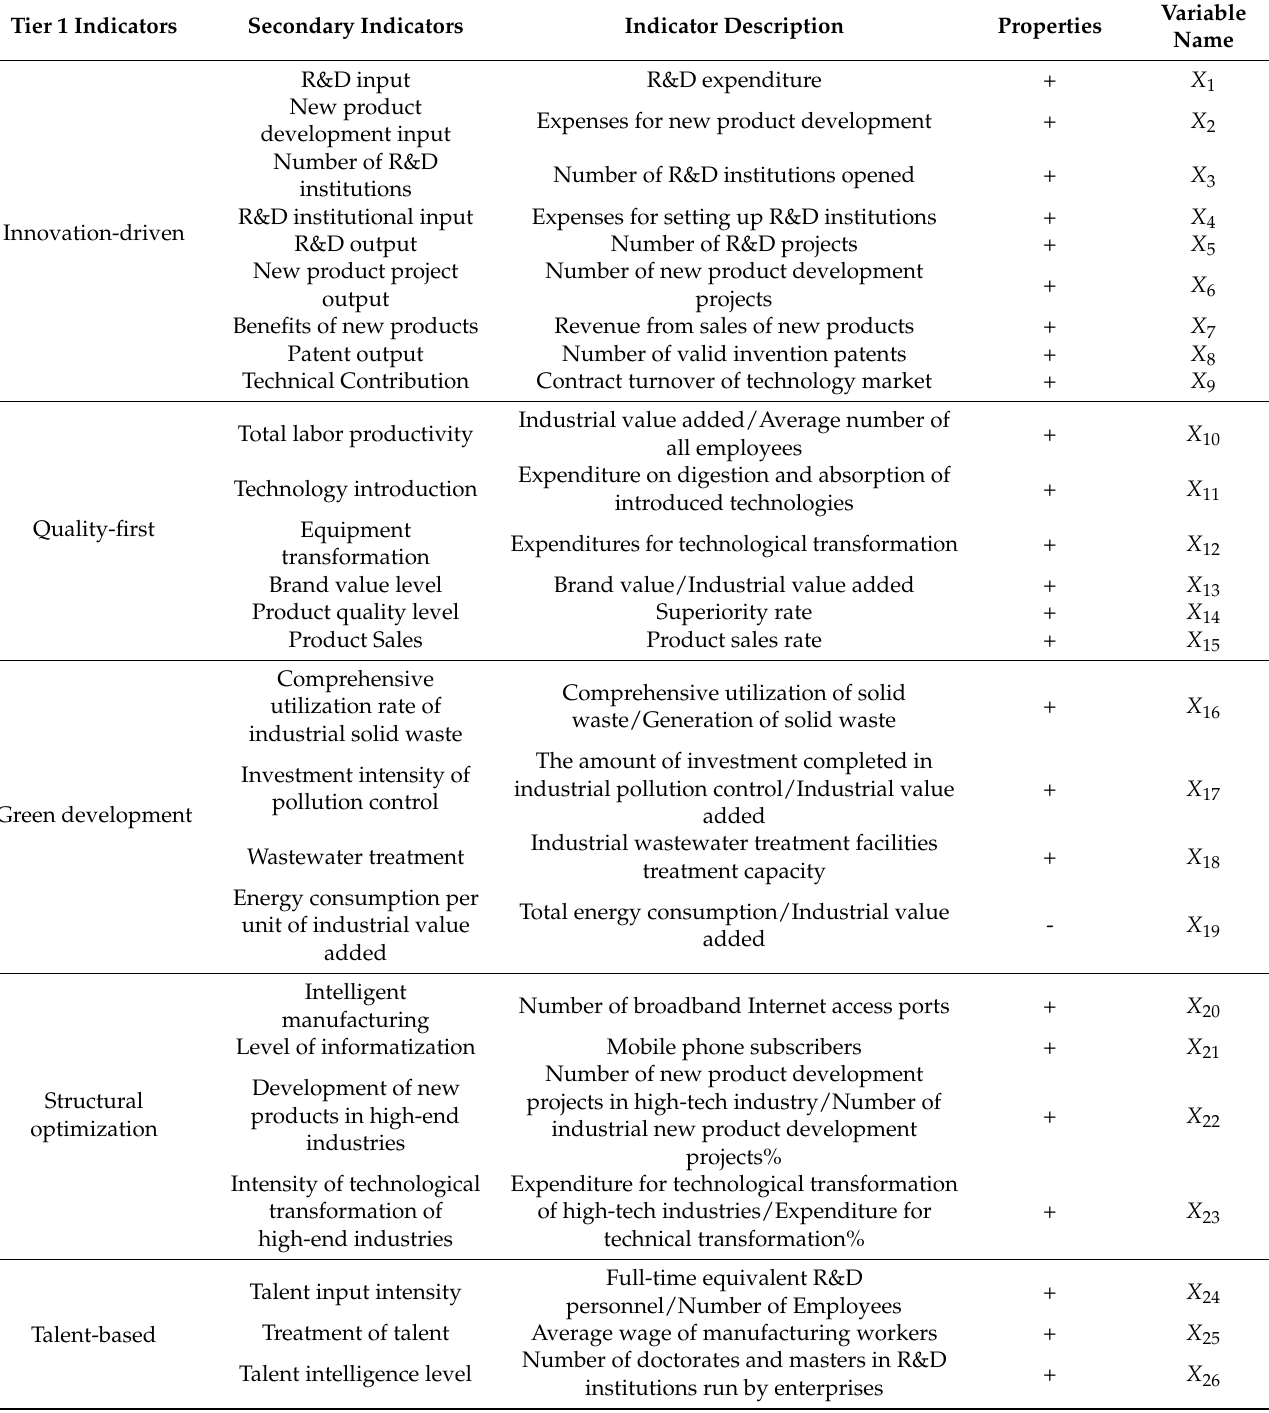
Table 1. HQDM comprehensive evaluation index system and index